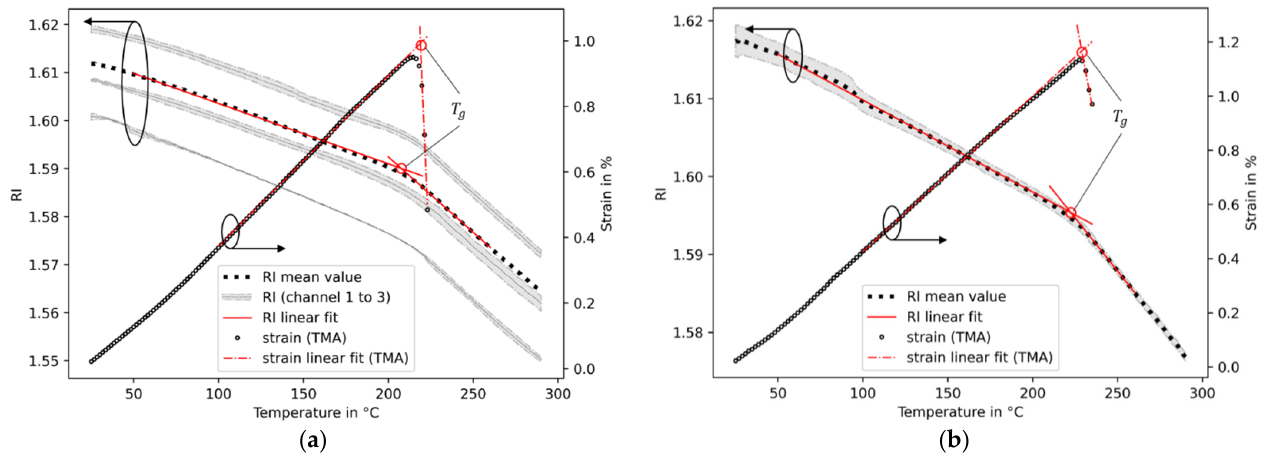
Figure 5. Results of the Fresnel reflectometer refractive index (RI) measurements and thermal strains derived from TMA of PEI ( a ) and PES ( b ), including glass transition temperature T g derived from the intersection points. The grey areas refer to the standard deviations of the corresponding curves.